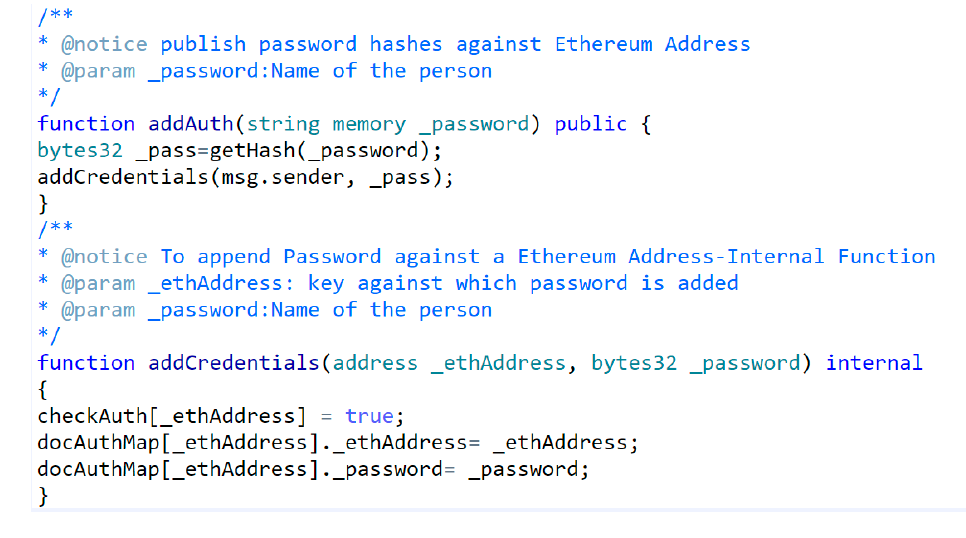
Figure 16. Code snippet of Adding Auth Credentials.